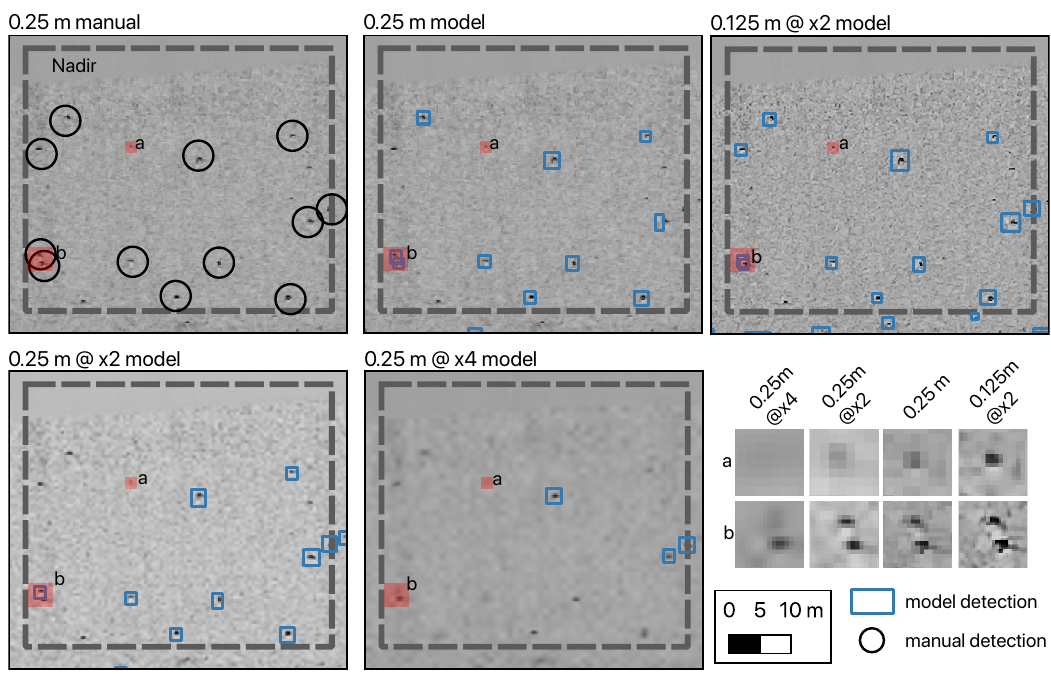
Figure 7. Subsets of the native and upscaled mosaics for the isolated boulder facies. Manual and model detections are marked. Insets detail the appearance of individual boulders in the different mosaics. The location of the shown mosaic subset in the validation mosaic is marked in Figure